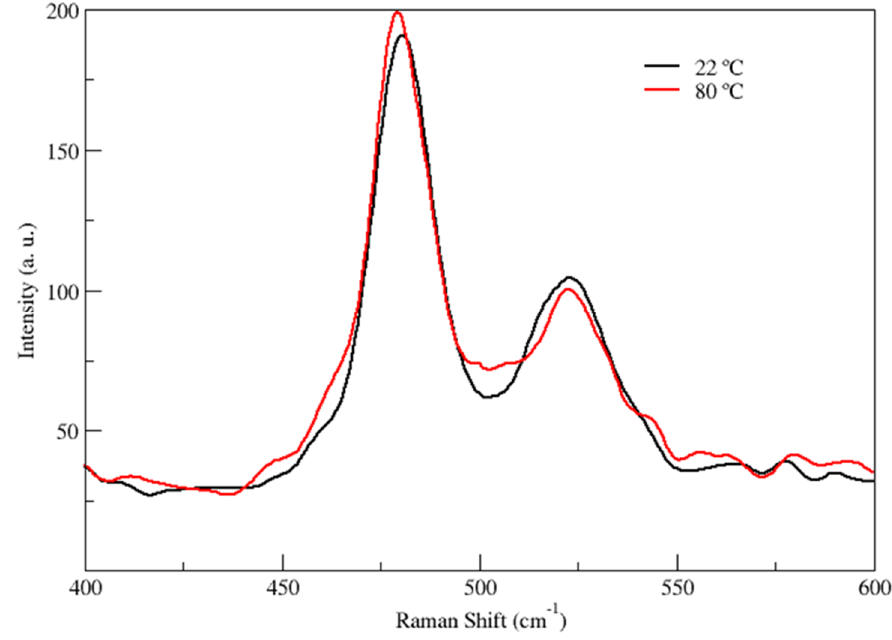
Figure 10. Temperature dependence of Raman intensities at 480 and 525 cm −1 of EG.